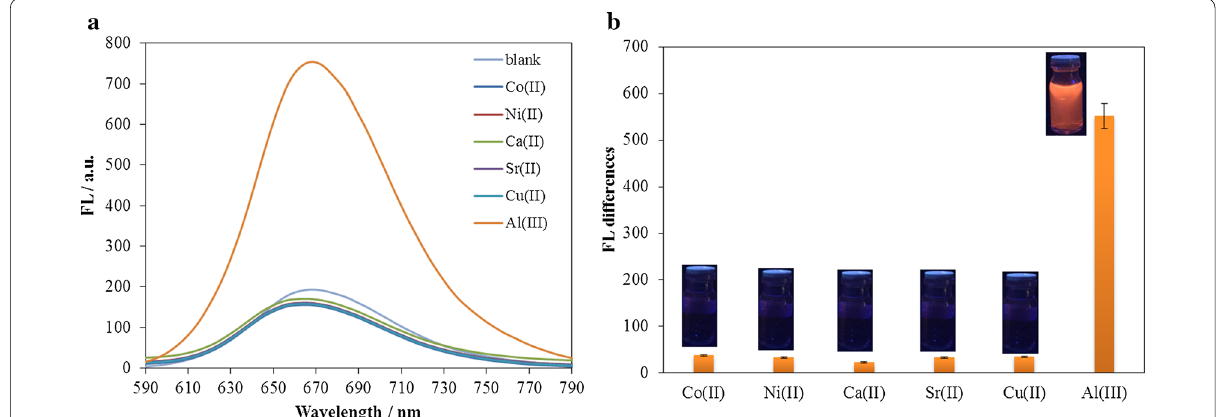
Fig. 11 a The fluorescence intensity ( λ exc. 388 nm) changes of ARLD-5 electrode after adding 120 μM of Al 3 + and interfering ions, b the = fluorescence intensity differences for Al 3 + detection compared to interfering